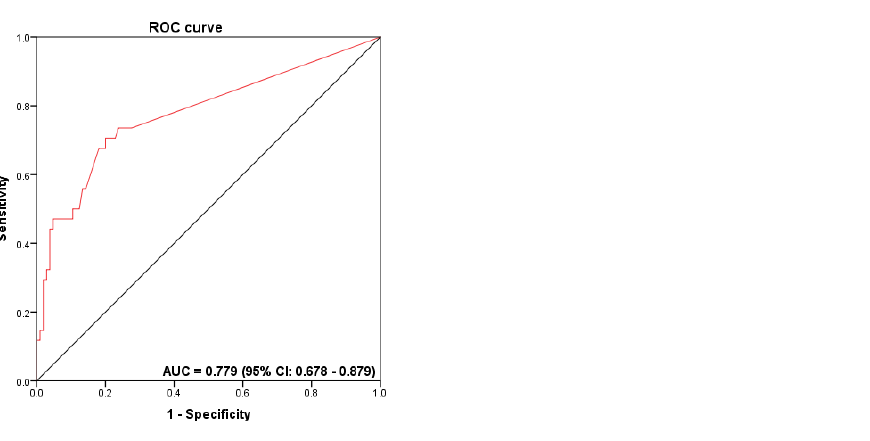
Table 3. Concordance of Fusobacterium nucleatum ( Fn ) detection in FFPE CRC cases by ddPCR and qPCR methods.